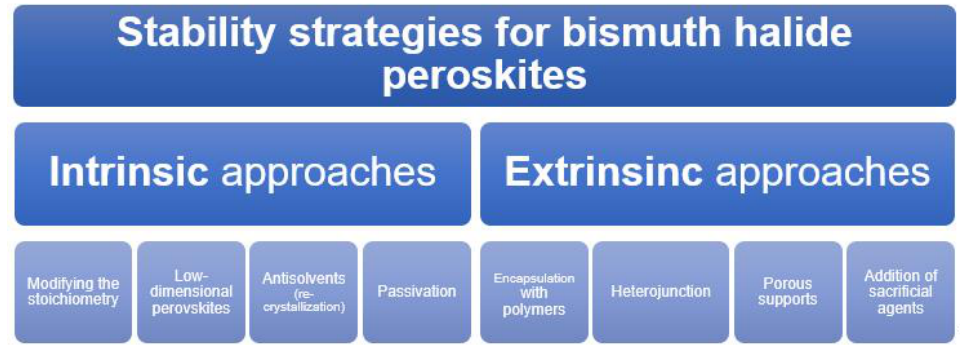
Figure 6. Current strategies proposed to increase the stability of bismuth halide perovskites.